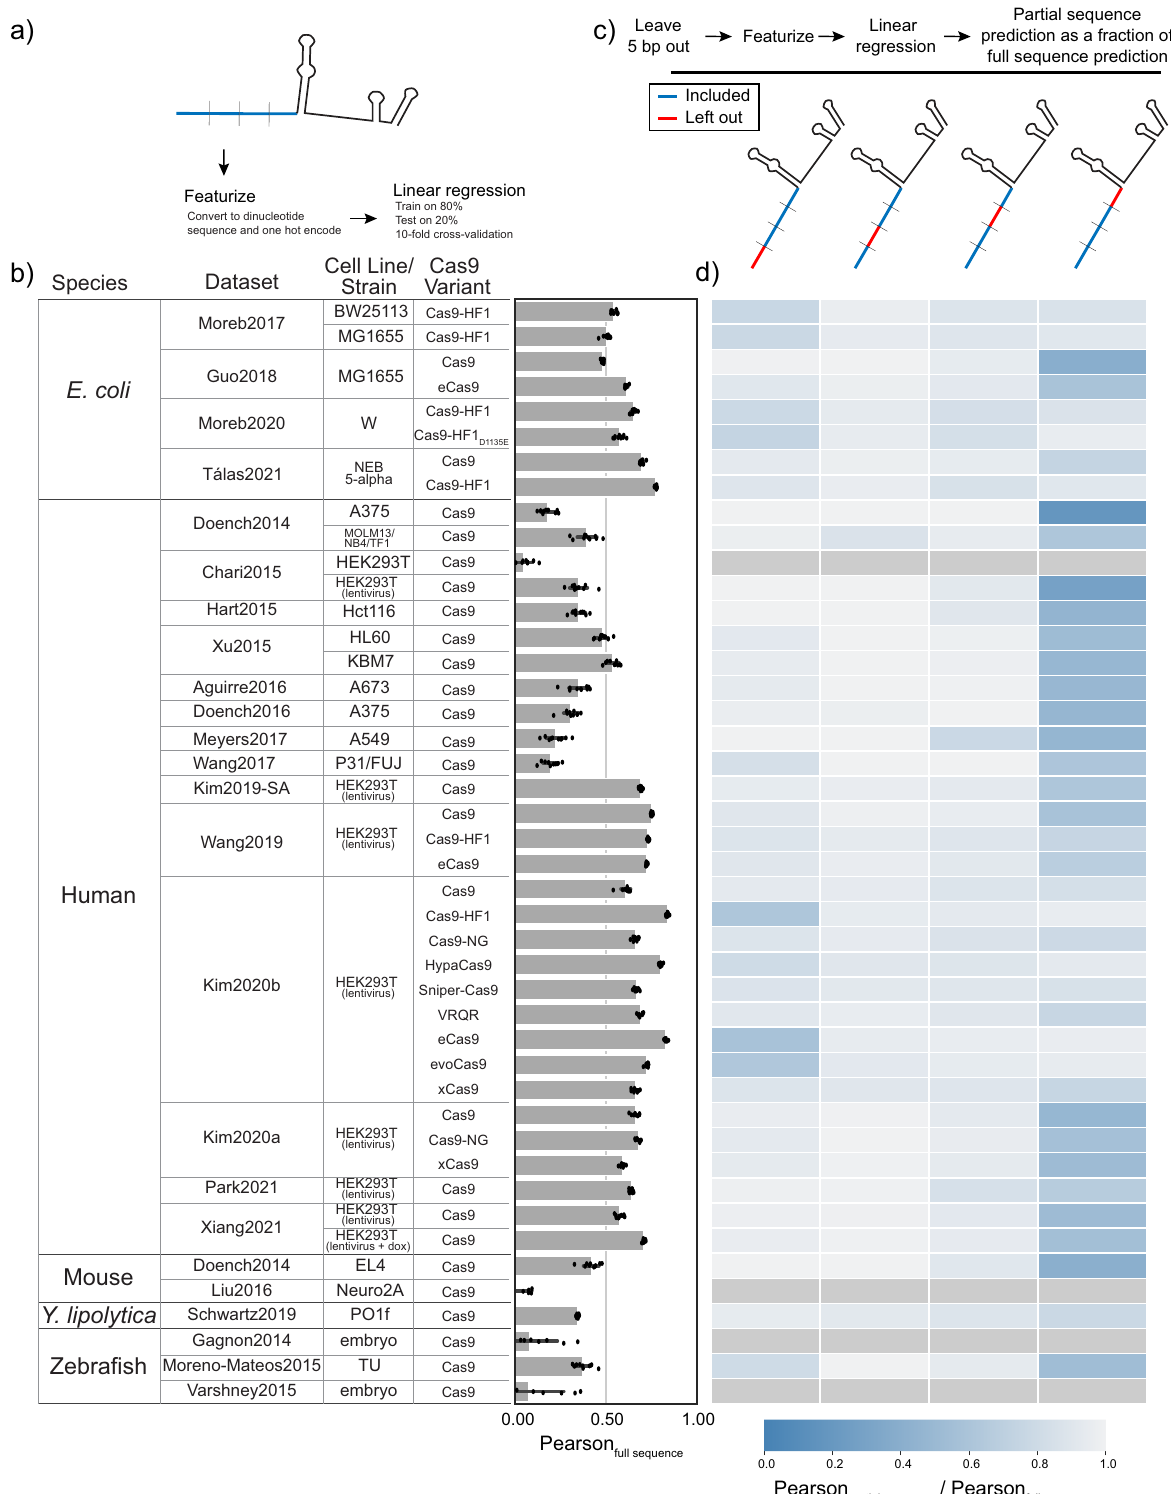
1.0 Pearson / Pearson partial sequence full sequence